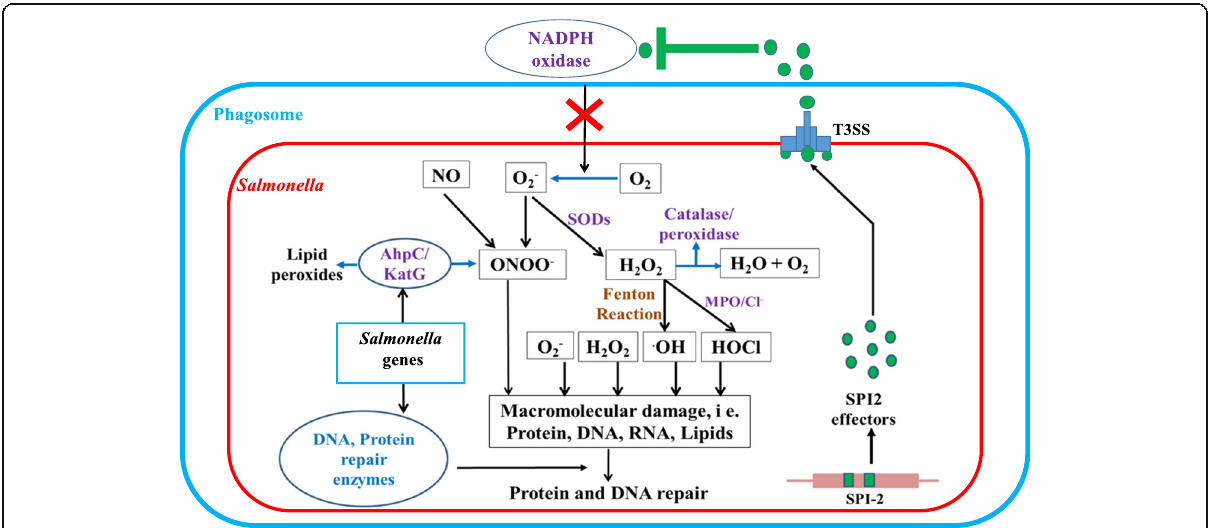
Fig. 1 Antioxidant defenses of Salmonella : Phagocytes produce an array of ROS/RNS which exert microbicidal effect by damaging macromolecules. Salmonella handles ROS/RNS in three ways. First, by injecting SPI2 effectors into the host phagosome, Salmonella inhibits NADP H oxidase assembly thus interfere with the O 2 − production. Second, various primary antioxidants of Salmonella directly inactivate ROS/RNS. Third, DNA and protein repair enzymes restore the functions of damaged DNA, and